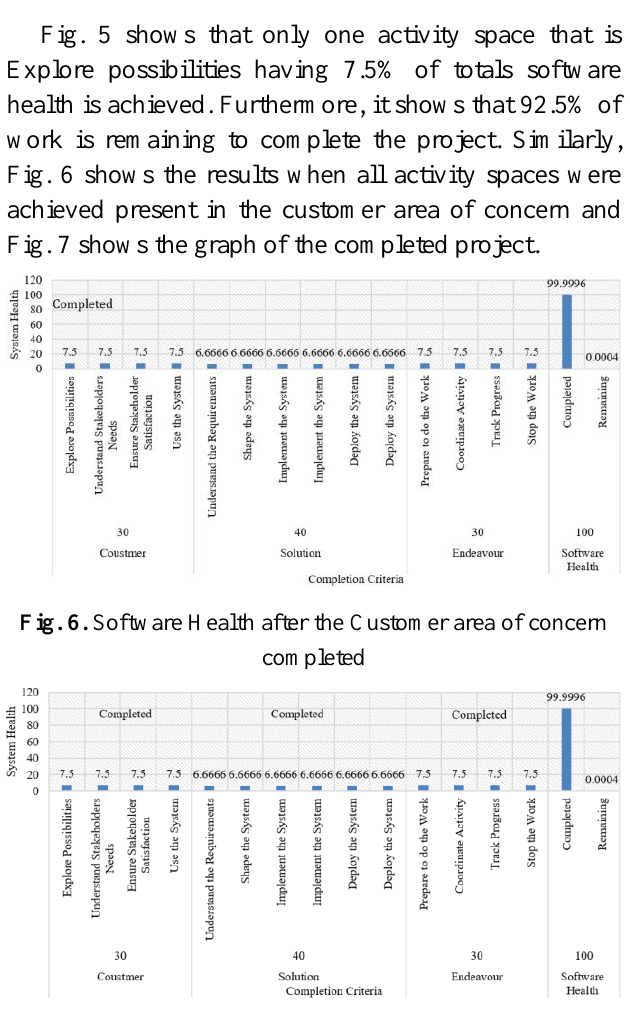
Fig. 7. Software Health after completion of the project Results show that one can measure the health of software projects using ontology automatically. The results are compiled in seconds using ontology while literature shows that manually it is time-consuming to deal with a huge amount of data. Hence our hypothesis is